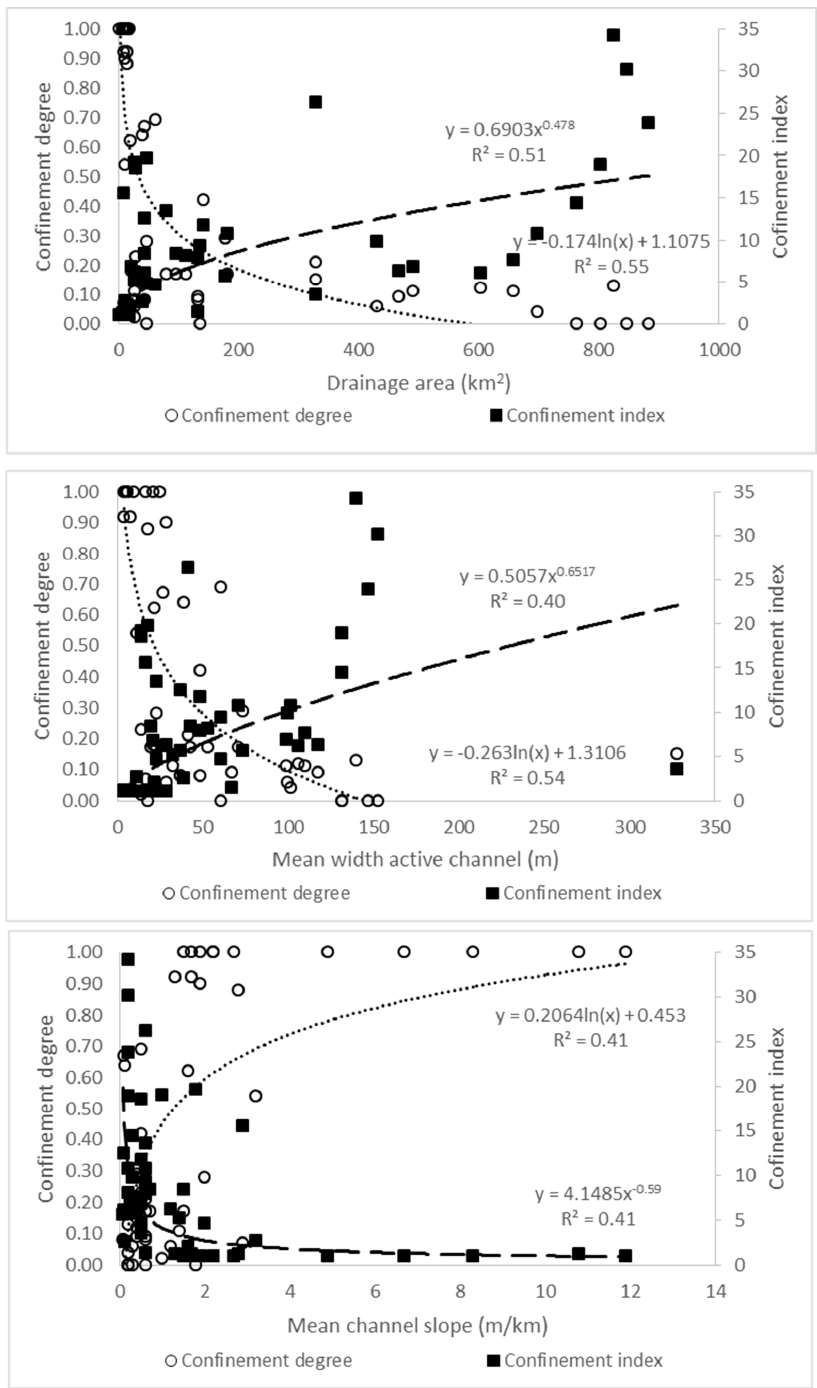
Figure 6. Confinement degree and index vs. drainage area, mean width of the active channel and mean channel slope for all reaches identified in the Dittaino River.